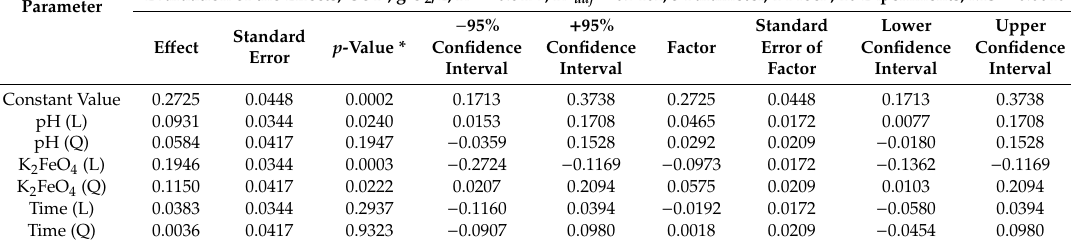
Table 3. Statistical parameters of the experiments using CCD / RSM with Statistica 13–evaluation of the e ff ects.